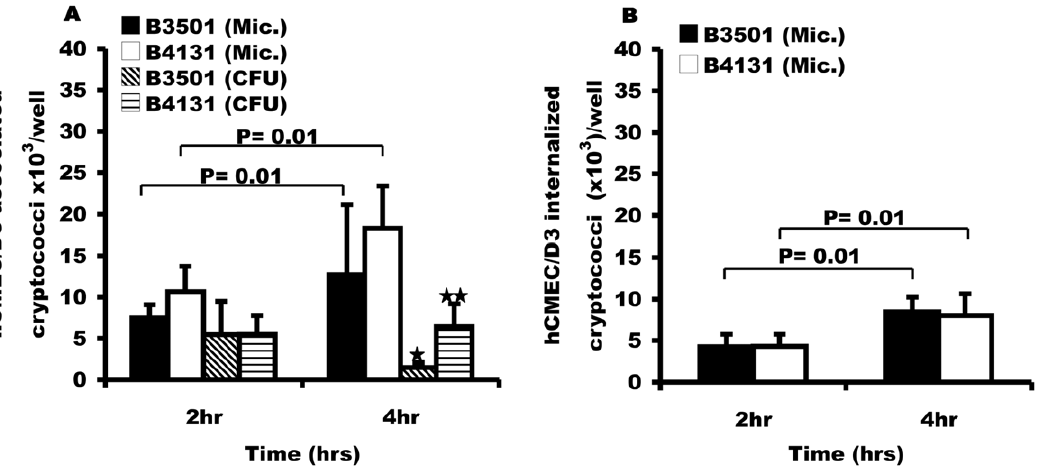
capsule for cryptococcal penetration of the blood-brain barrier.